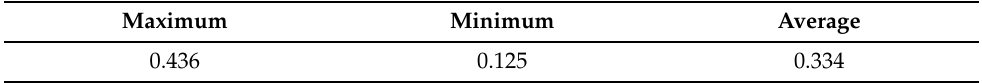
Table 6. Particle concentration in Pastaza River (kg m − 3